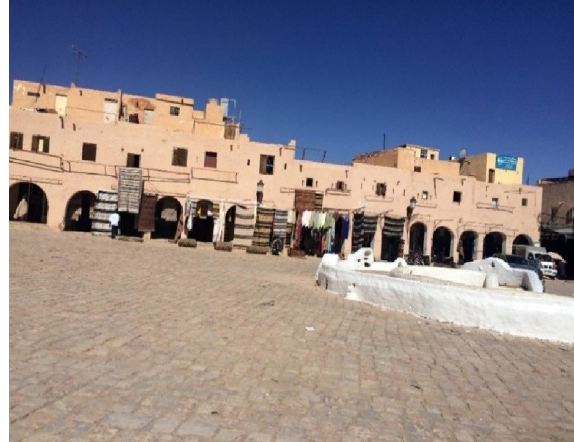
Fig. 4. The market place of Ghardaïa taken around noon.